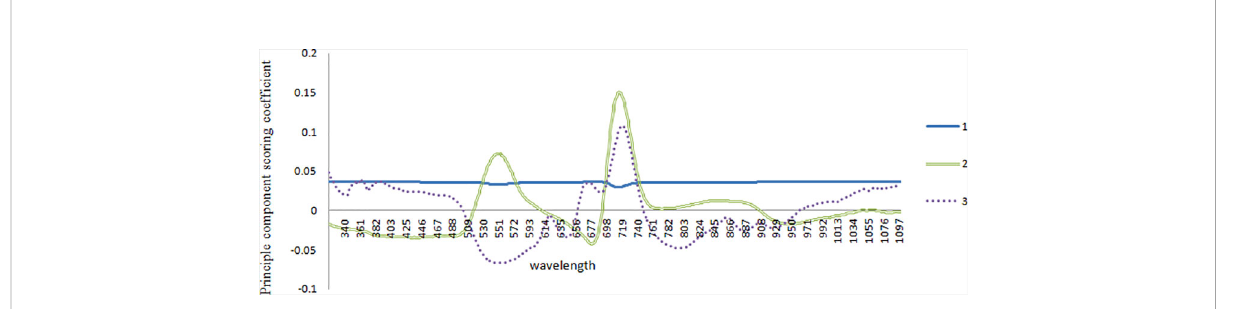
FIGURE 4 Correlation between the standard quantity coef fi cient and the wavelength coef fi cient with PCA.